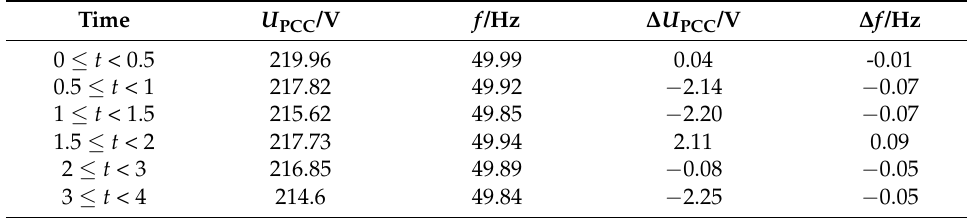
Table 2. Steady-state value of U PCC and output frequency.